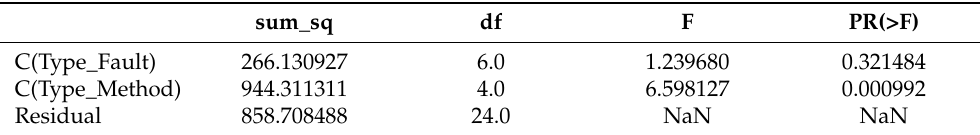
Table 13. Anova2 test: real cases.